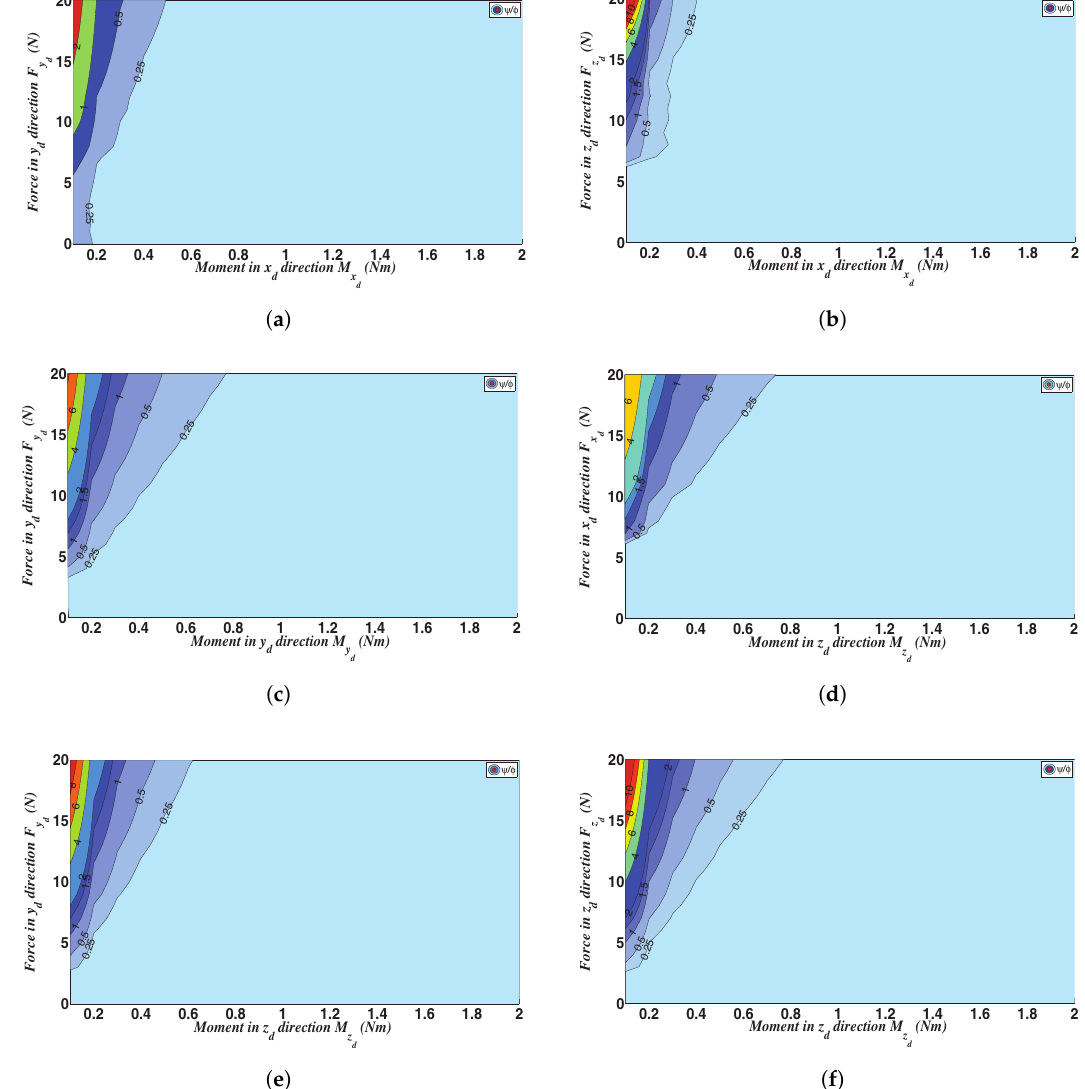
Figure A3. Contour plots of ψ / φ for all the loading cases: ( a ) moment, M x M x , and force, F z ; ( c ) moment, M y d d and force, F y ; ( f ) moment, M z d